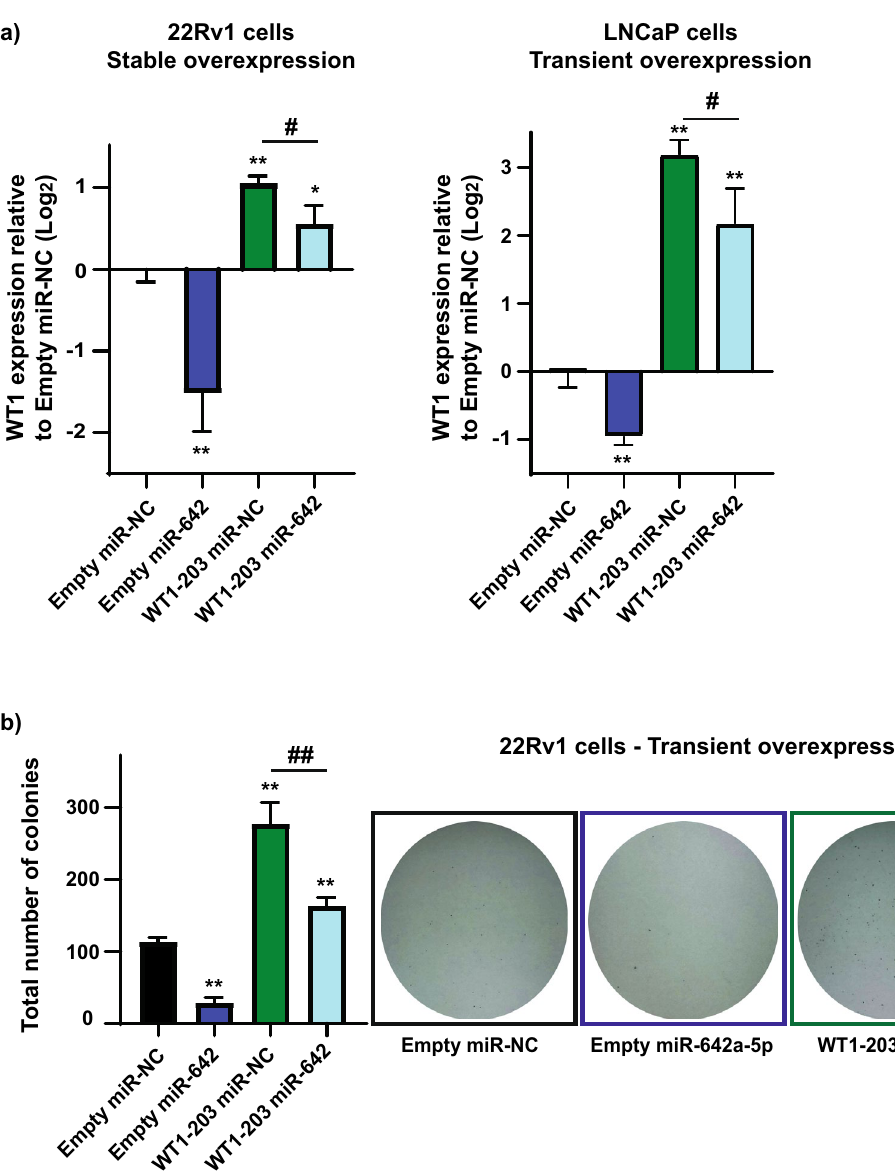
Figure 6. WT1 overexpression increases colony formation and miR-642a-5p rescues this effect. ( a ) RT-qPCR analysis of WT1 gene expression following stable or transient LeGO-iT2-WT1-203 or LeGO-iT2-Empty plasmids, and overexpression of miR-642a-5p or miR-NC in 22Rv1 and LNCaP PCa cells. Expression of WT1 is normalized to HPRT housekeeping gene expression, calculated using the 2 −ΔΔCt method, and relative to Empty vector + miR-NC. Error bars = SE; n = 3; * p < 0.05, ** p < 0.005 relative to Empty vector + miR-NC. # p < 0.05 WT1- 203 + miR-NC relative to WT1-203 + miR-642a-5p. ( b ) Colony formation assay of 22Rv1 PCa cells 14 days post transient WT1 overexpression/empty vector transfection and miR-NC/miR-642a-5p (30 nM) co-transfection. Error bars = SD; n = 3; ** p < 0.005 relative to Empty vector + miR-NC. ## p < 0.005 WT1-203 + miR-NC relative to WT1-203 +